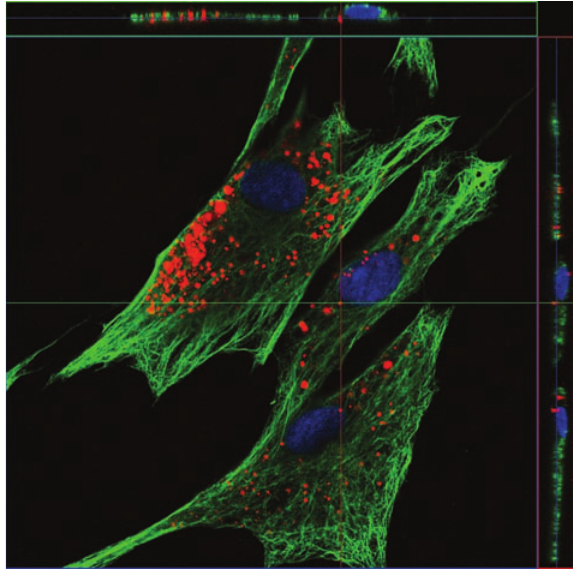
Figure2:SpatialdistributionofQDs(red)withinthecells.Confocal image of labeled PSCs immunostained for Vimentin (green). Nuclei were stained with DAPI